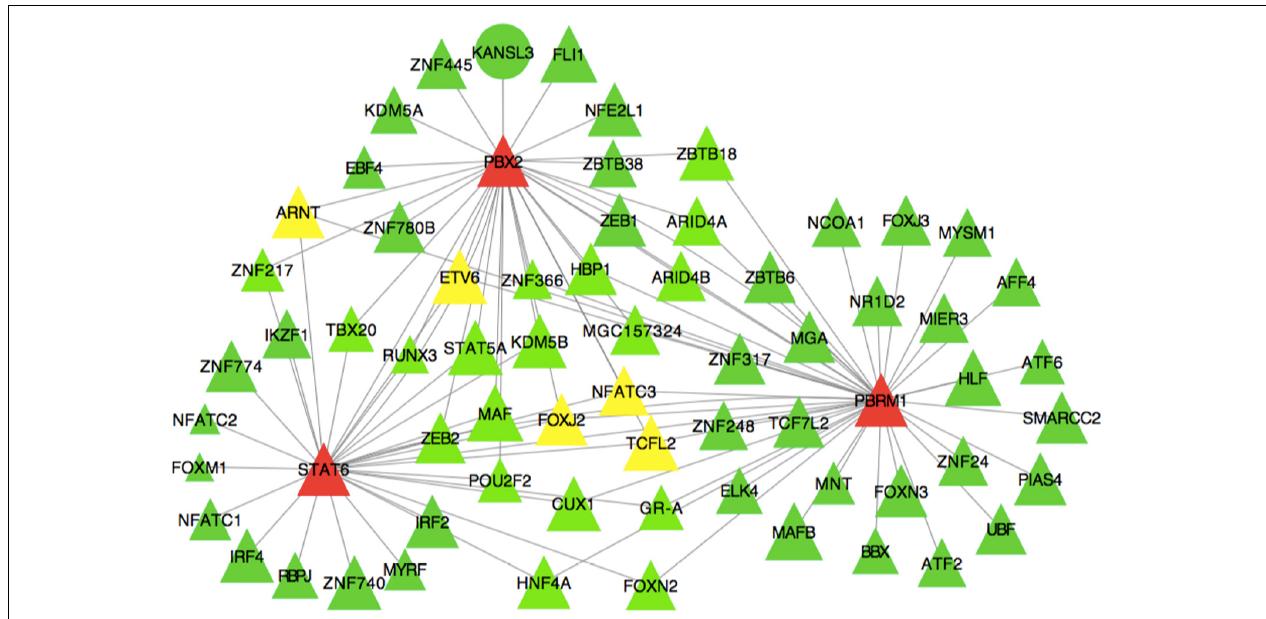
FIGURE 3 | Subset of the liver co-expression network showing the best trio of TF and its predicted target genes in pre- and post-puberty Brahman heifers. Each node represents a gene. Nodes represented as triangles are TF and other coding sequences are represented as ellipses. Edges represent significant interaction between nodes. Node color indicates the number of connections of a specific node in the network. The color spectrum ranges from green to red for low and high number of